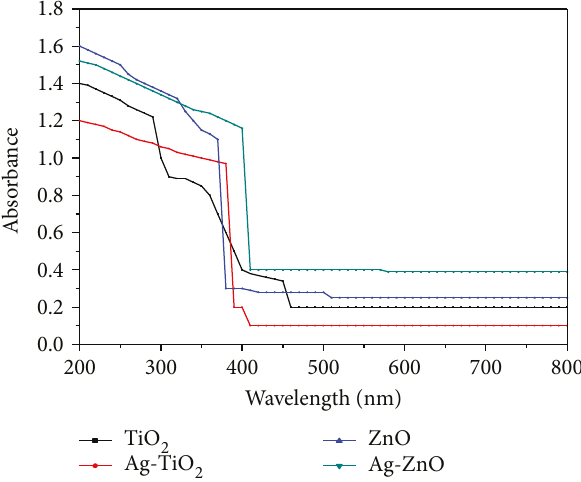
Figure 6: UV-Vis di ff use re fl ectance spectra of the TiO Ag-TiO , and 2